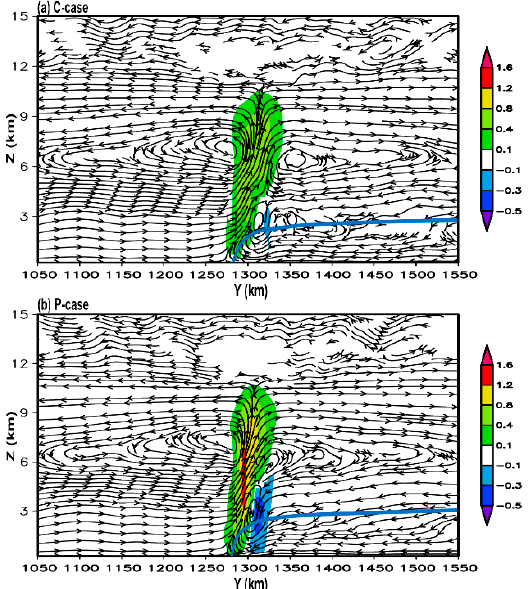
Figure 15. Vertical cross sections of zonal mean vertical velocity ( w , shading) and cross-front ageostrophic circulation ( v - V g , w ) at 21 h for ( a ) C-case and ( b ) P-case. Only a 500 km × 15 km of the domain is presented.